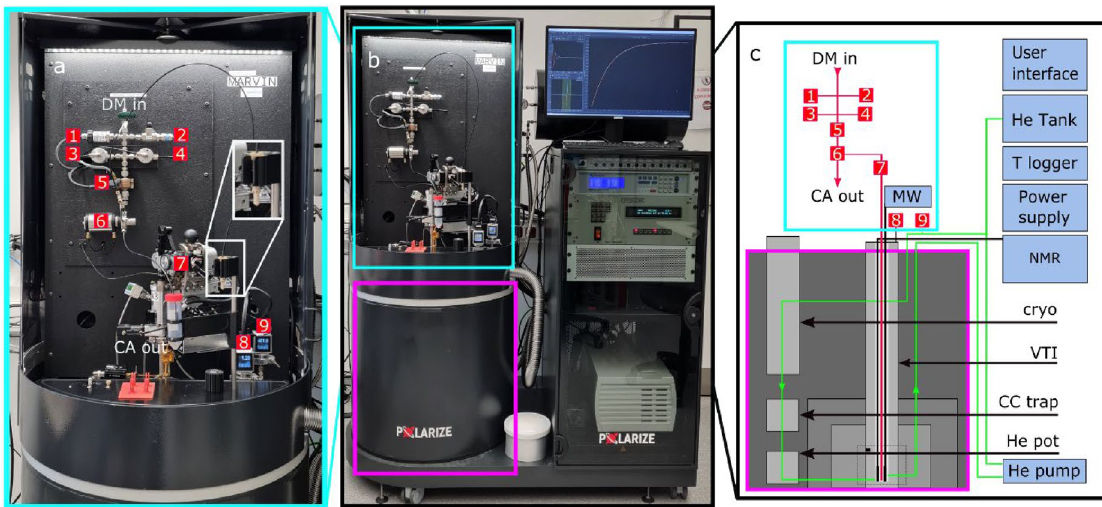
Figure 1. Photo ( a , b ) and diagram ( c ) of the polarizer used in this work. The polarizer consists of a dissolution module ( a ) mounted on the magnet ( b section, magenta square) and a rack for auxiliary parts. The dissolution module ( a ) contains an inlet for the dissolution medium (DM), a heater for DM (5), a Swagelok manifold (1–4), a switch valve (6), the sample cup and an outlet. The magnet ( b section, magenta square) is equipped with a variable temperature inset (VTI) which is cooled down to 1.4 K by evacuating a bath of liquid helium at the bottom of the VTI. The pressure of helium gas inside the VTI and in the inlet are shown by P1 (8) and P2 monitors respectively. The DNP probe inside the VTI consists of a tunnel for the sample cup, a waveguide to transmit the microwaves, and an NMR coil at the bottom. The sample is inserted into the VTI via an airlock (7) on top. The rack is used to house the pump circulating the Helium of the VTI, an NMR spectrometer, the magnet power supply, temperature controllers and the user interface. Figure c shows a schematic view of the polarizer naming all the main